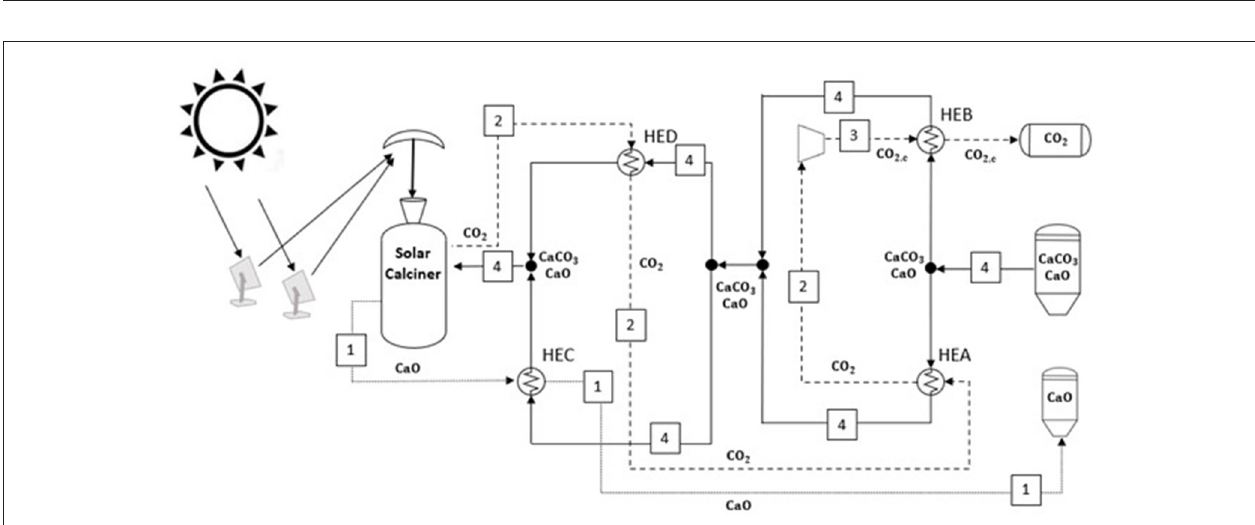
FIGURE 7 | Minimum energy consumption network in the solar energy storage side. The plant configuration results from the pinch analysis